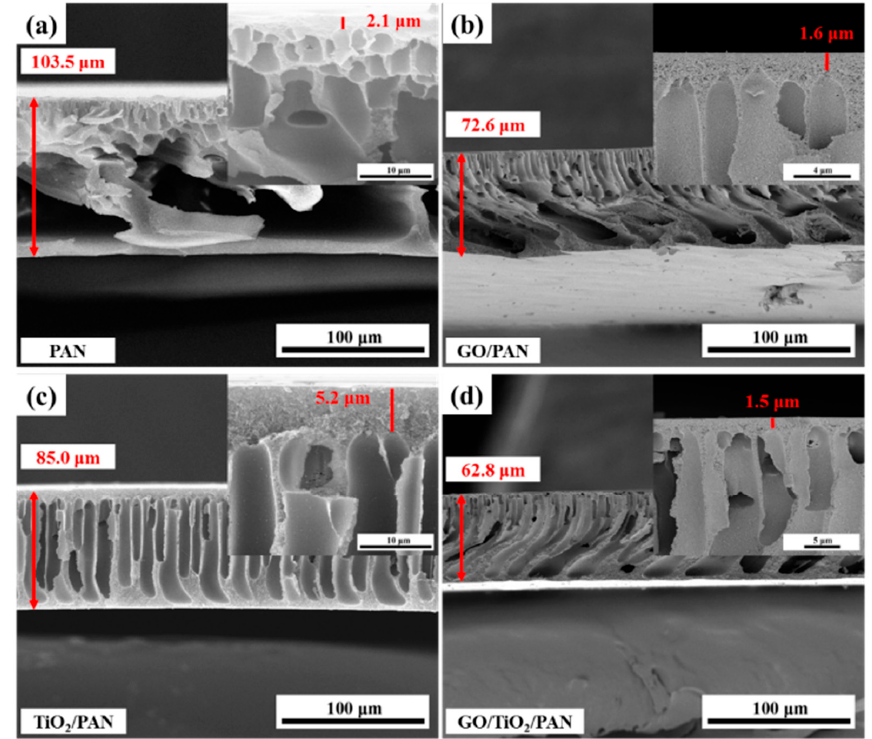
Figure 1. SEM images of the cross-sectional morphologies of the ( a ) PAN, ( b ) GO/PAN, ( c ) TiO 2 /PAN and ( d ) GO/TiO 2 /PAN membranes, and the amplified SEM morphologies of the four membranes’ cross-sections, respectively. The area indicated by the red arrow is the area of membranes thickness measurement.